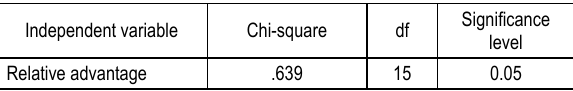
Table 3. The results of test of the relationship between relative advantage of solar water heater and adoption